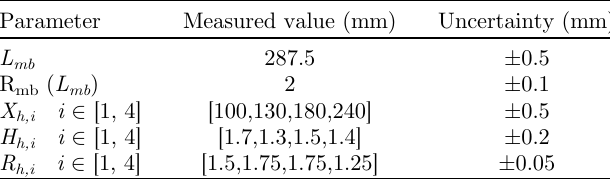
Figure 1. Sketch of the cylindrical tube with four side holes to be recovered. It is described by 15 geometric parameters (three for the main bore pro fi le and three for each of the four holes). Table 1. Direct geometric measurements of the design param- eters grouped together in the vector n